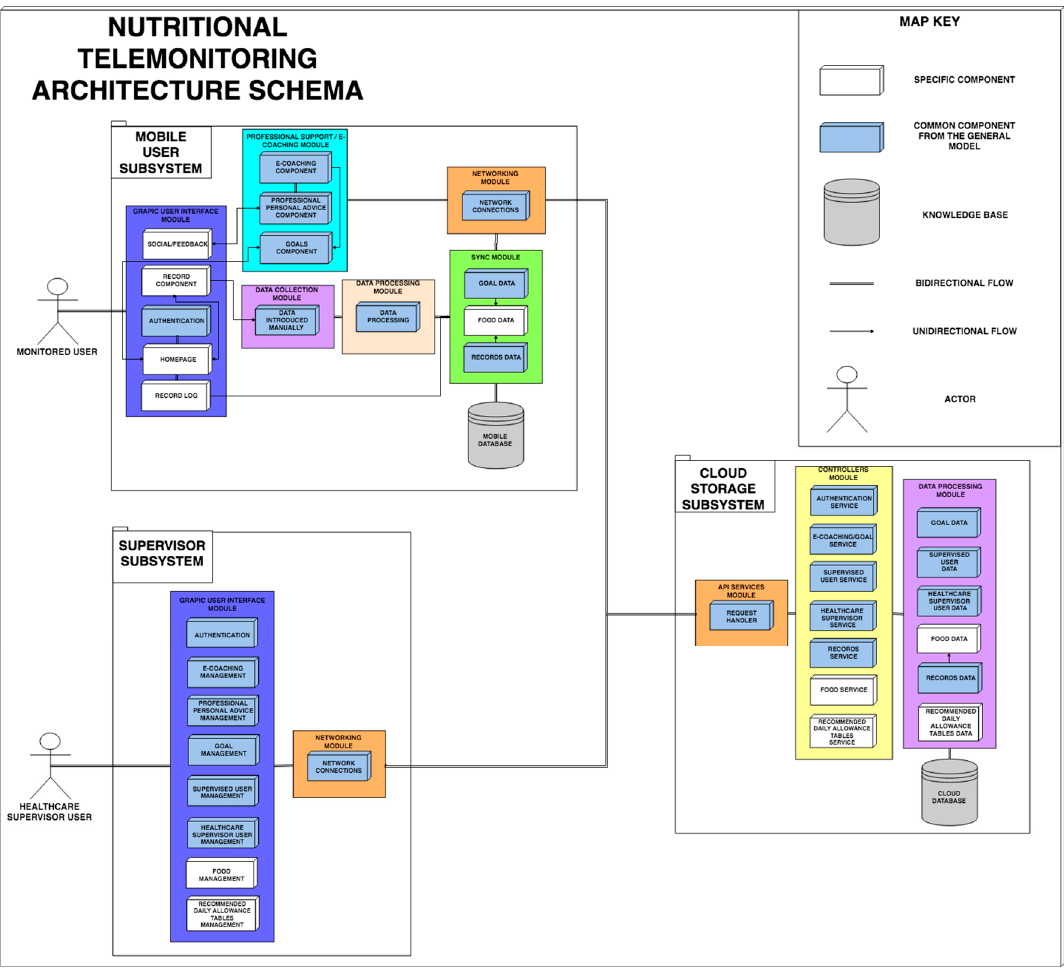
Figure 5. Schema of the architecture for nutritional telemonitoring (Food4Living).